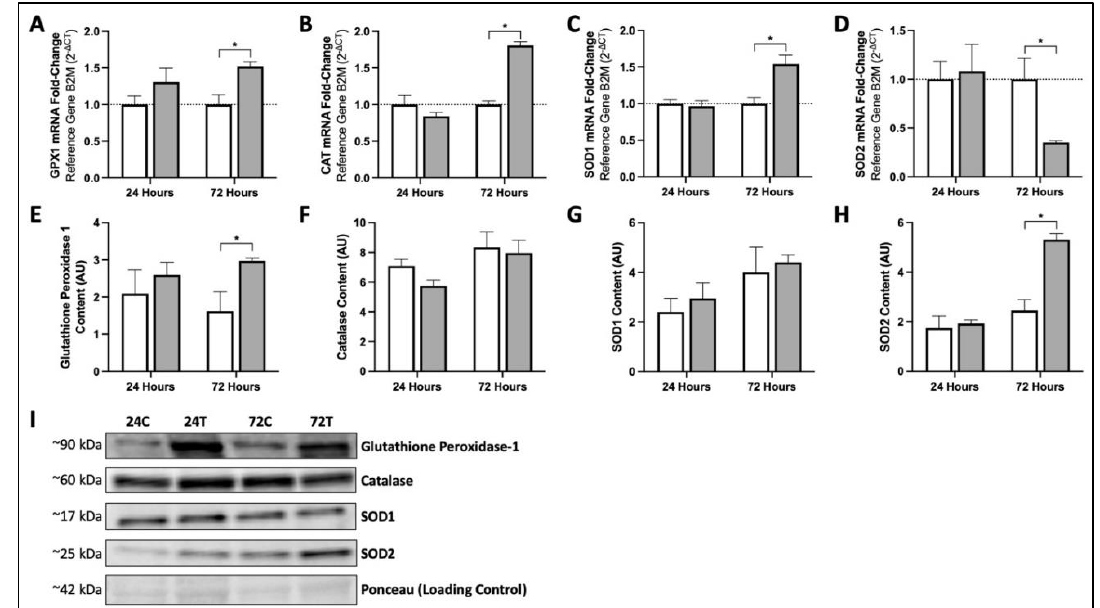
Figure 3. Seventy-two hours of MIS supplementation modifies mRNA and protein content of key cellular antioxidants in human fibroblasts. ( A ) GPX1 , ( B ) CAT , and ( C ) SOD1 mRNA content are significantly greater following 72 h of MIS supplementation. ( D ) SOD2 mRNA content is lower following 72 h of MIS supplementation. ( E – H ) Protein content of the formerly interrogated genes parallels the absence of change following 24 h of MIS supplementation. Following 72 h of MIS supplementation, however, glutathione peroxidase and SOD2 protein content are significantly higher. ( I ) Representative Western blot images depict protein content for proteins interrogated in E to H. White bars indicate CON treatment, grey bars indicate MIS treatment. n = 3 independent donor biopsies per group. Data are mean ± SEM. * indicates p < 0.05 via unpaired t -test.